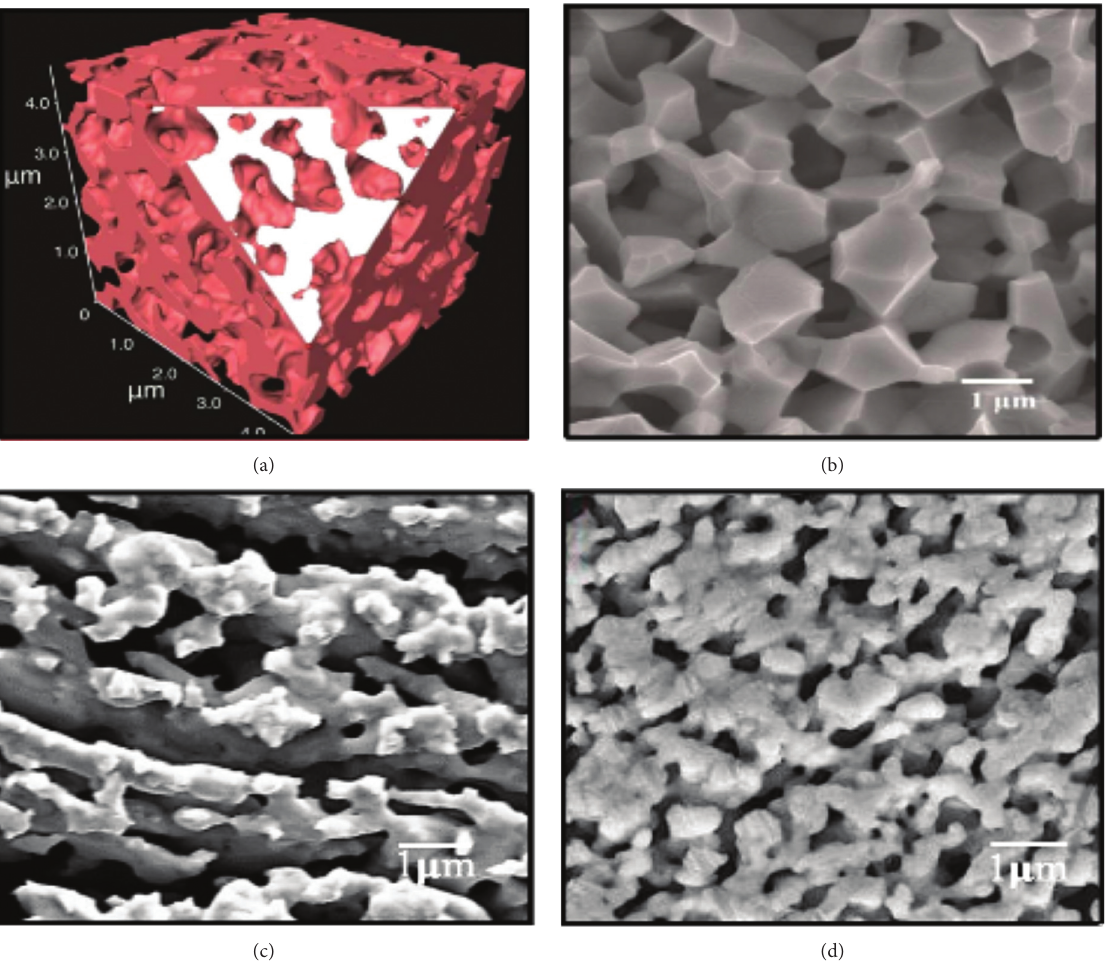
Figure 8: Reconstructed porous microstructure of SDC membrane: (a) 3D; (b) 2D SEM [26]; (c) porous Ag matrix after chemical dealloying [23]; (d) porous Ag matrix after electrochemical dealloying